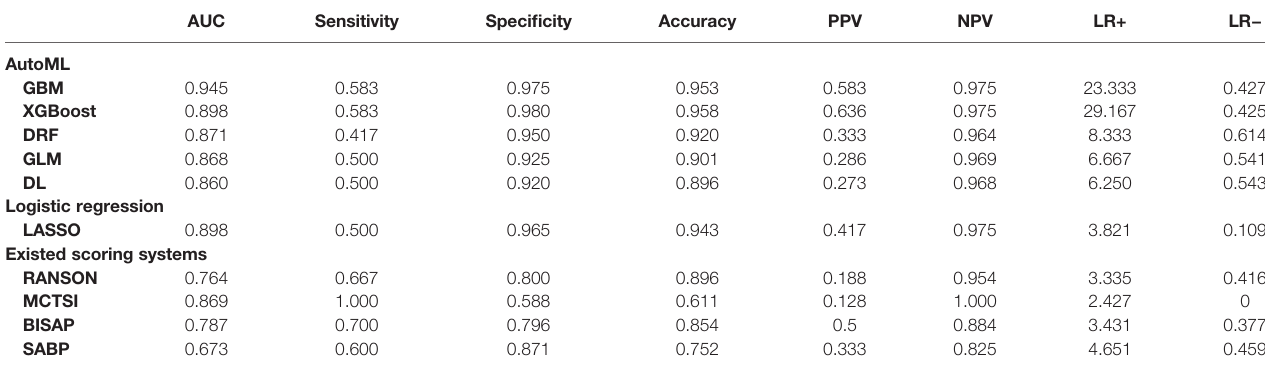
TABLE 2 | Comparison of LR and AutoML models for early prediction of SAP in the test cohort. AUC Sensitivity Speci fi city